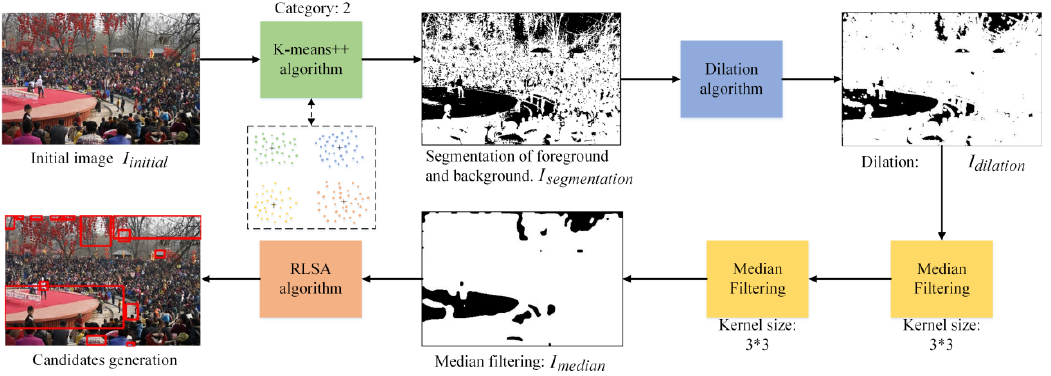
Figure 2. Overview of the proposed two-stage important area detection method. The method is built based on classification structure.